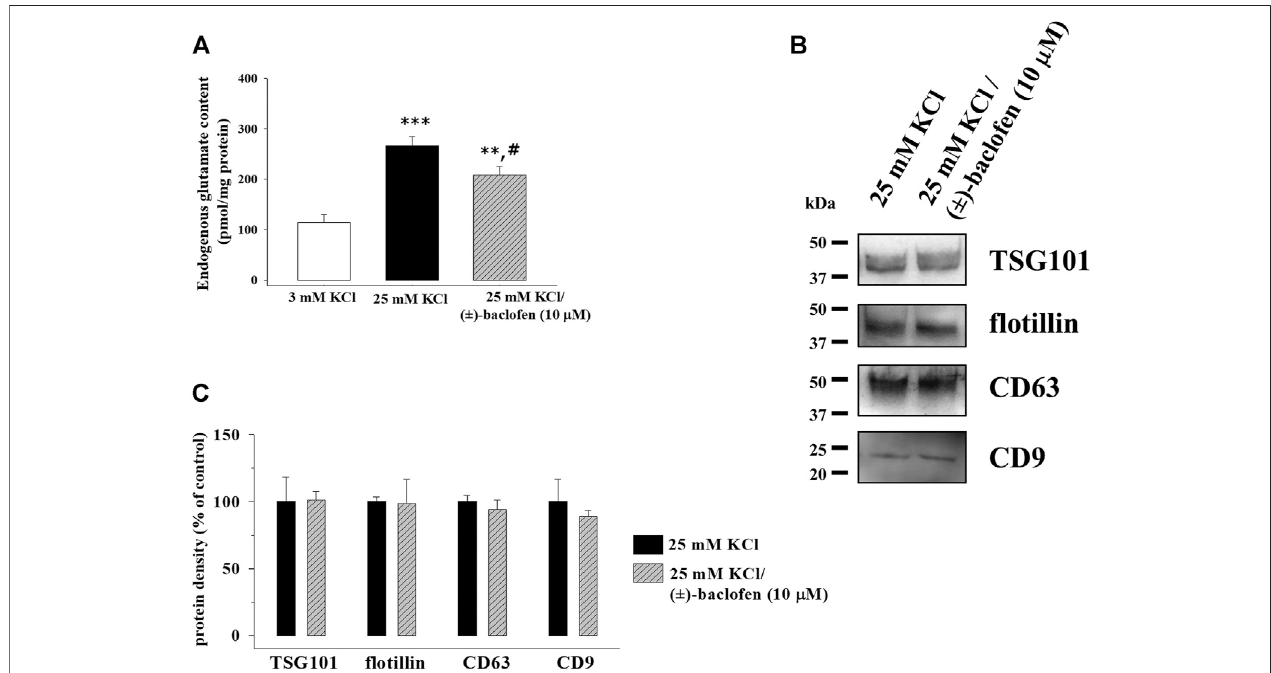
FIGURE6| Releaseofexosomes fromcorticalsynaptosomesisnotmodi fi edbypresynaptic GABA B receptoractivation.Synaptosomeswereincubated for2 min ina25 mMKClmediumintheabsenceorinthepresenceoftheGABA B receptoragonist( ± )-baclofen(10 μ M). (A) Endogenousglutamatecontentinthesupernatantsof the synaptosomes incubated in 3 mM KCl medium (empty bar), 25 mM KCl medium (black bar), and 25 mM KCl/( ± )-baclofen (10 μ M) medium(rising right hatched gray bar).Theendogenousglutamatecontentisexpressedaspmol/mgsynaptosomalproteins.Datarepresentthemean ± SEMoftheanalysisof n (cid:1) 12samples.** p < 0.01 vs. control; *** p < 0.001vs. control; # p < 0.05vs. 25 mM KCl. (B) Western blotexperiments were carried out toanalyze TSG101, fl otillin-1, CD63, and CD9 protein content in theexosomal fractions isolated from the supernatants of synaptosomesstimulated with 25 mM KCl alone (lane 25 mM KCl) or in the presence of( ± )-baclofen (10 μ M)(lane25 mMKCl/( ± )-baclofen(10 μ M)).Theimageisrepresentativeoftheresultsof n (cid:1) 4(TSG101), n (cid:1) 6(CD63), n (cid:1) 9( fl otillin-1),and n (cid:1) 10(CD9)Westernblot analyses. (C) Quanti fi cation of the change in TSG101, fl otillin-1, CD63, and CD9 proteins in the exosomal fraction from the supernatants of the synaptosomes exposed to25mM/( ± )-baclofen(10 μ M) medium (rising right hatched gray bars)when compared to25 mMKCl medium (black bars). Resultsare expressed aspercent ofcontrol (25 mM